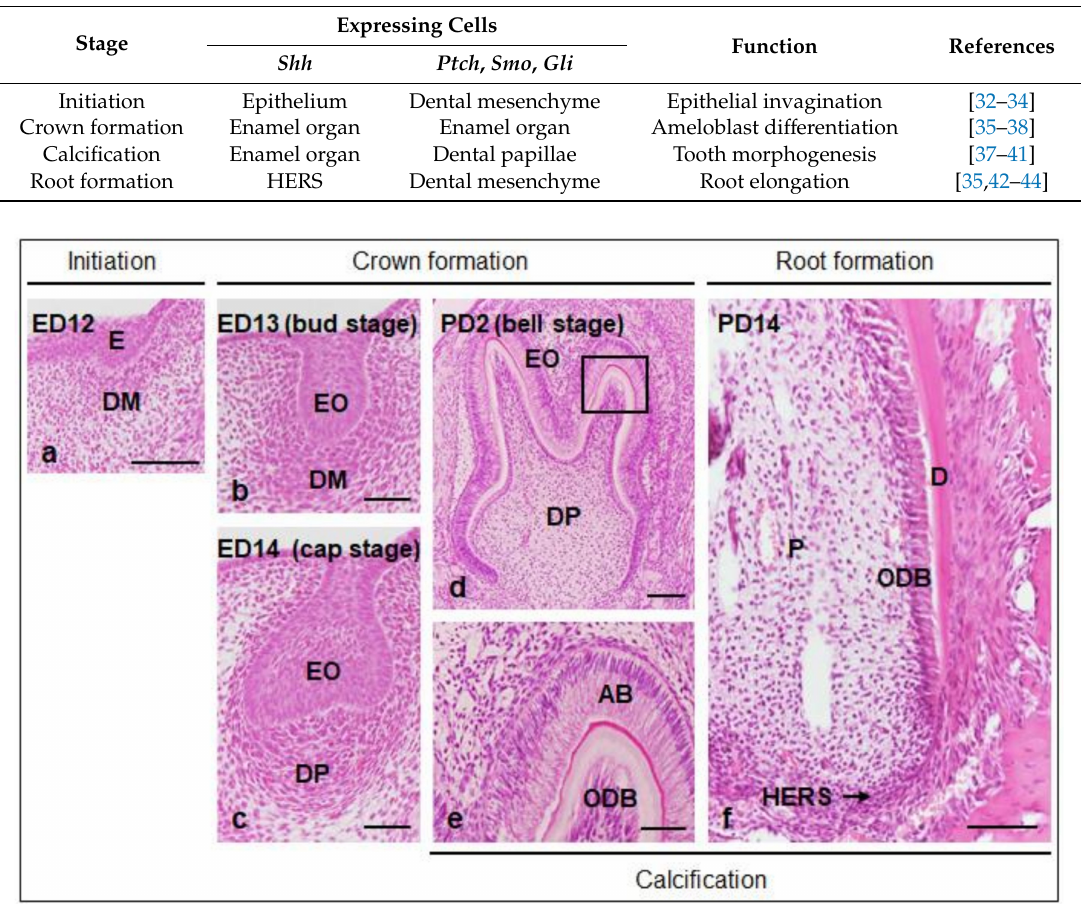
Table 1. Roles of Shh signaling during tooth development.